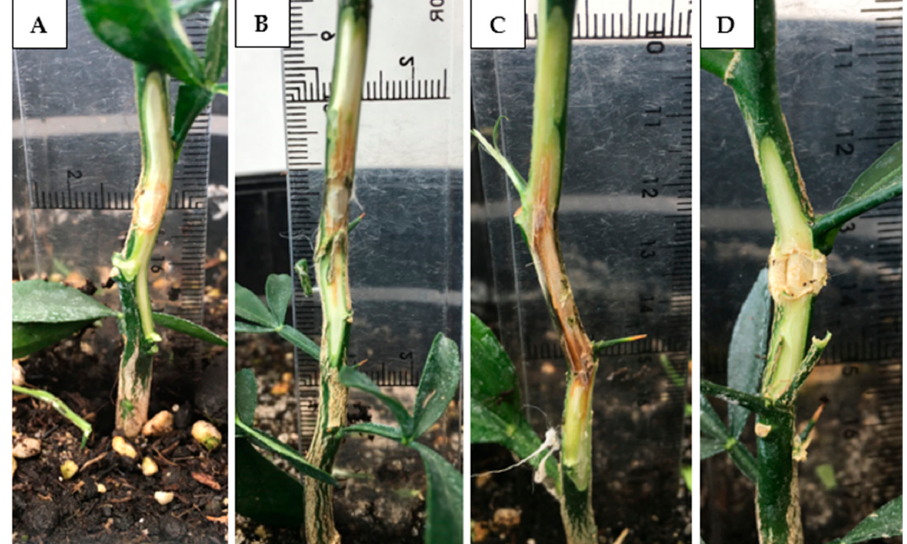
Figure 2. Foot rot lesion length level of P. nicotianae 30 days post inoculation in different rootstocks: UFR-6 (7.88 mm) ( A ); Carrizo citrange (24.03 mm) ( B ); 2247 × 6070-02-2 (43.57 mm) ( C ); cork borer lesion (5.00 mm) in non-inoculated UFR-6 ( D ).